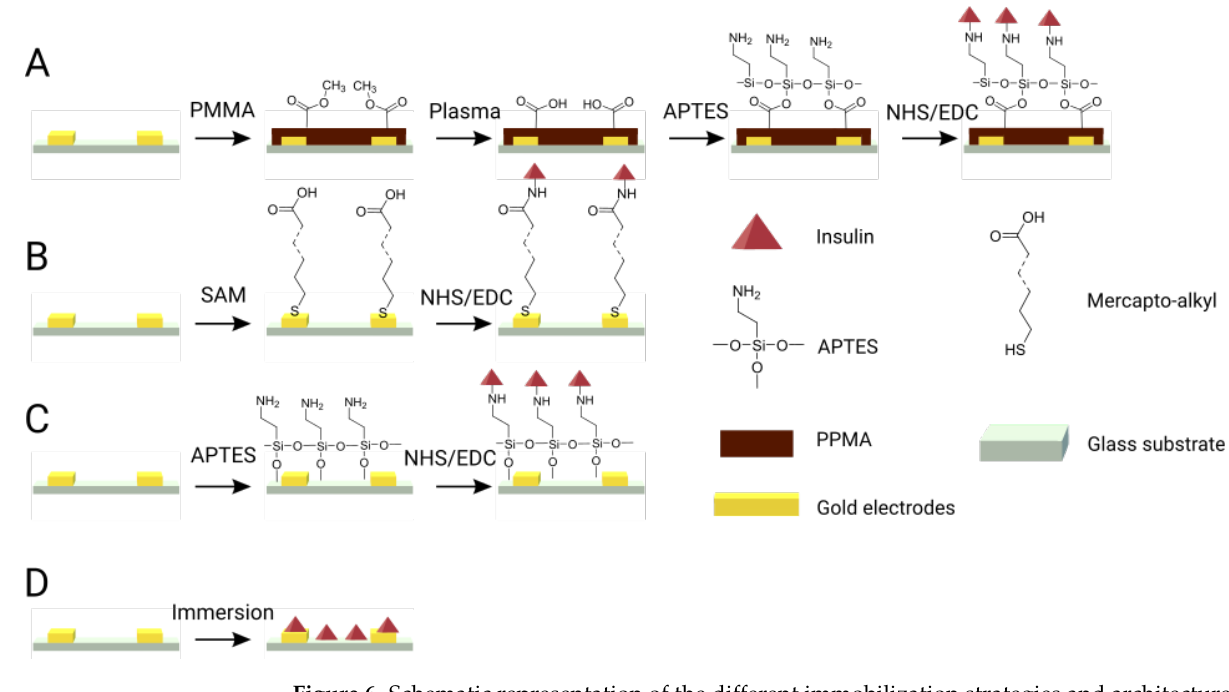
Figure 6. Schematic representation of the different immobilization strategies and architectures for the conjugation of insulin on IDEs. ( A ) spin-coated PMMA deposition; ( B ) mercapto-alkyl SAM deposition, ( C ) APTES covering; and ( D ) passive adsorption. Adapted from Castiello et al. [19].